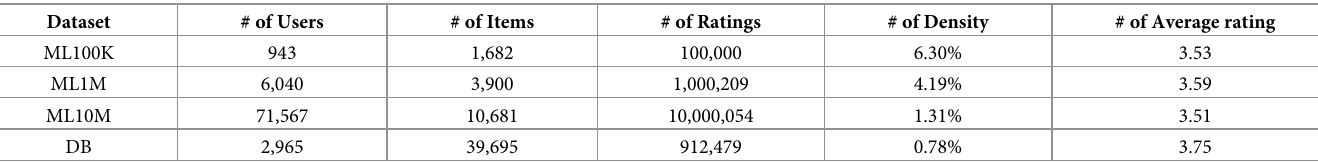
Table 3. The basic information of four